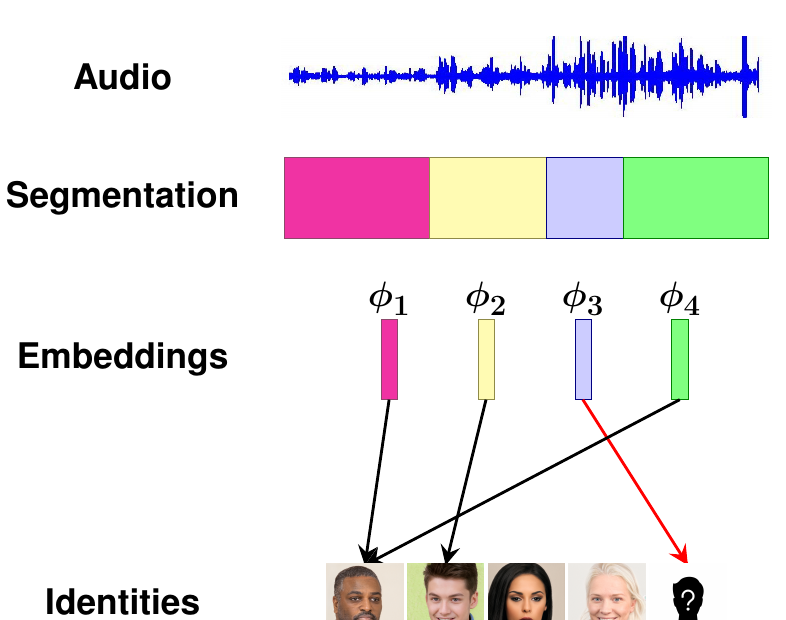
Figure 3. Diagram of the direct assignment approach. The embeddings obtained from the different parts of the given audio are independently assigned to the identities. These assignments can be done to enrolled identities or the generic unknown one (red